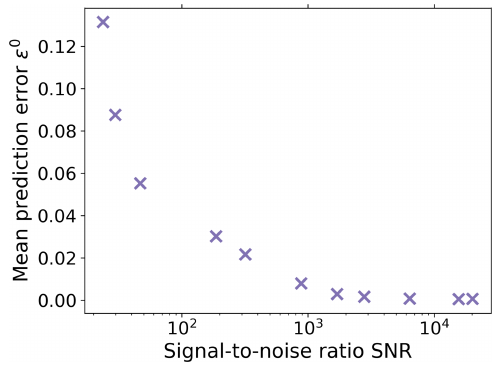
Figure 4. Mean prediction error (Eq. 37) of the recovery when de- riving χ(t) for different values of the SNR. As the SNR increases, the recovery of χ(t) improves. To illustrate the most general case where χ(t) is not known to be monotonic, we do not apply the monotonicity check (step 6 of Fig.